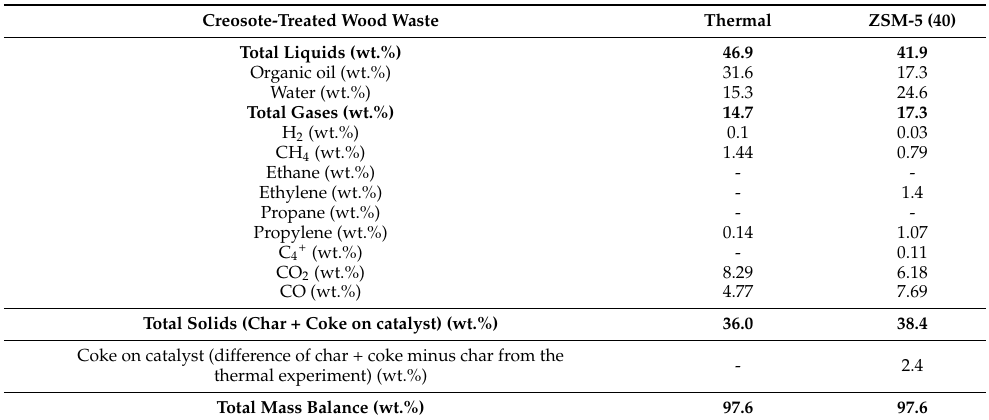
Table 6. Product yields in thermal and catalytic fast pyrolysis of creosote-treated wood waste (NAS-3), at 600 ◦ C, obtained on fixed-bed reactor (Catalyst/feed mass ratio =